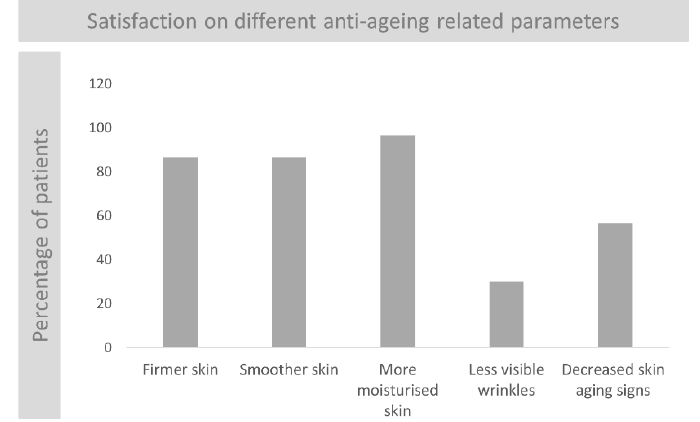
Figure 7. Evaluation of satisfaction at D84: percentage of subjects manifesting satisfaction on different anti-ageing related parameters.